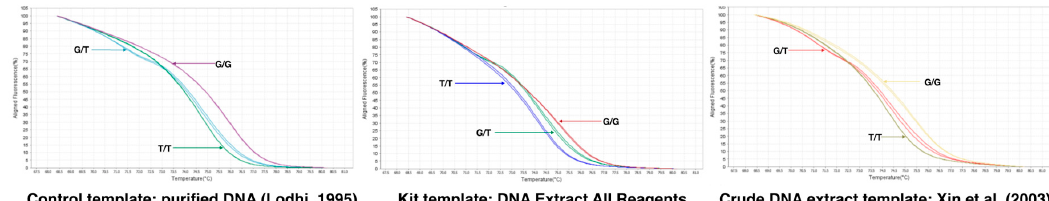
Figure 7. qPCR-High Resolution Melting analysis for the detection of the SNP [G/T] with the e7_VviAGL11 marker. Comparison of the aligned melt curves between homozygous seedless (RU × SU:16.48 and 33.34 experimental genotypes), heterozygous seedless (Sultanina and Crimson Seedless), and seeded genotypes (Muscat of Alexandria and Red Globe). The developed marker is suitable for applications in high-throughput routines sustained by qPCR-HRM and commercial (DNA Extract All Reagents from Applied Biosystems, Foster City, CA, USA) or lab-made crude DNA extracts (protocol described by Xin et al. [27] as a template.